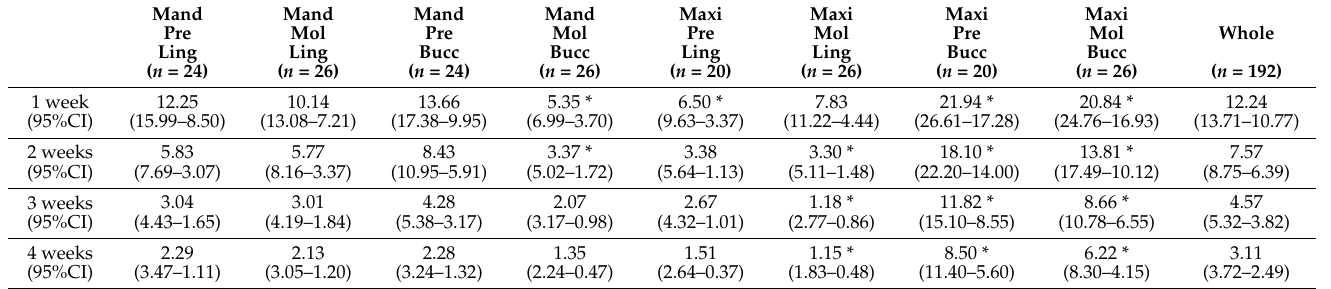
Table 2. The average Hybrid Coat adhesion rate (%) of the area divided into eight sections.